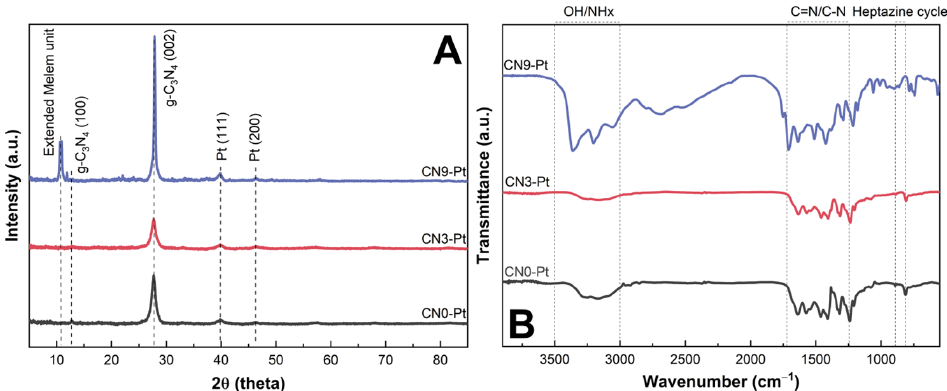
Figure 1. ( A ) XRD patterns and ( B ) FTIR spectra of CNx ‐ Pt samples.